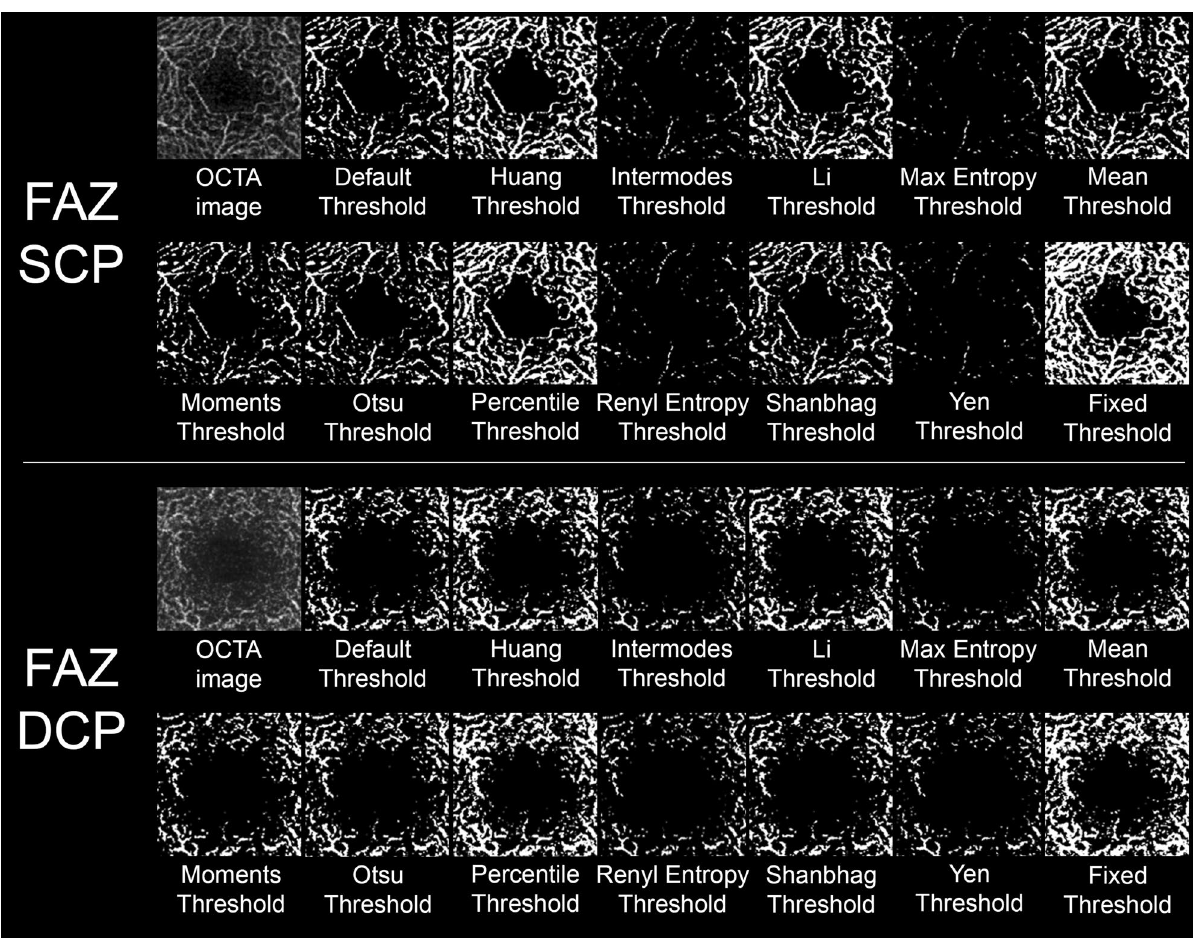
Figure 5. Binarized FAZ reconstructions obtained through all the included binarization